Question: Write a descriptive caption for this figure.
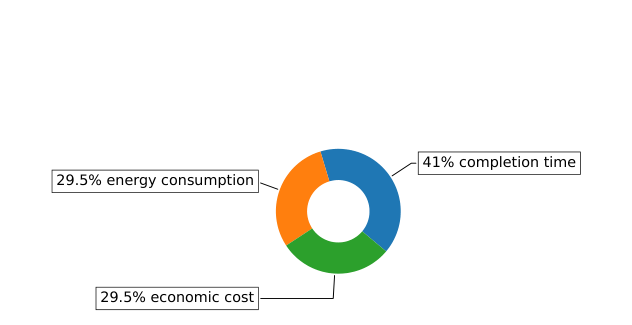
Answer: Percentages of research articles addressing the time, energy, or cost objectives.